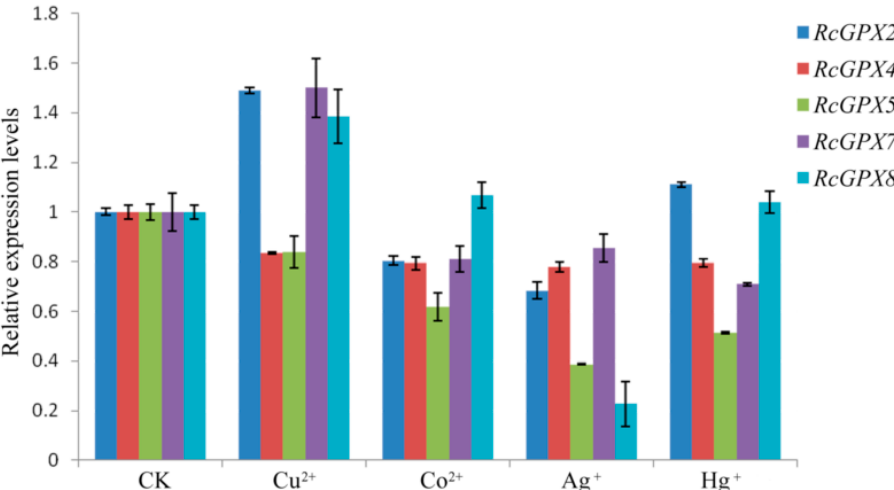
Figure 7. Expression levels of RcGPXs genes for leaves under heavy metal conditions. Heavy metal compounds were used to treat whole seedlings of R. crenulata for 6 h. The seedlings were exposed to MS (Murashige and Skoog) media contained different heave mental ions and the concentrations were 25 μ M Hg + (HgCl), 50 μ M Cu 2+ (CuSO 4 ), 50 μ M Co 2+ (CoCl 2 ), and 50 μ M Ag + (AgNO 4 ). CK indicted the negative control which seedlings were exposed for MS media for 6 h. The total RNA was extracted from young leaves. mRNA levels were normalized with respect to RcGAPDH and were expressed relative to the CK values, which were given an arbitrary value of 1. Data represent the means ± SE of at least three